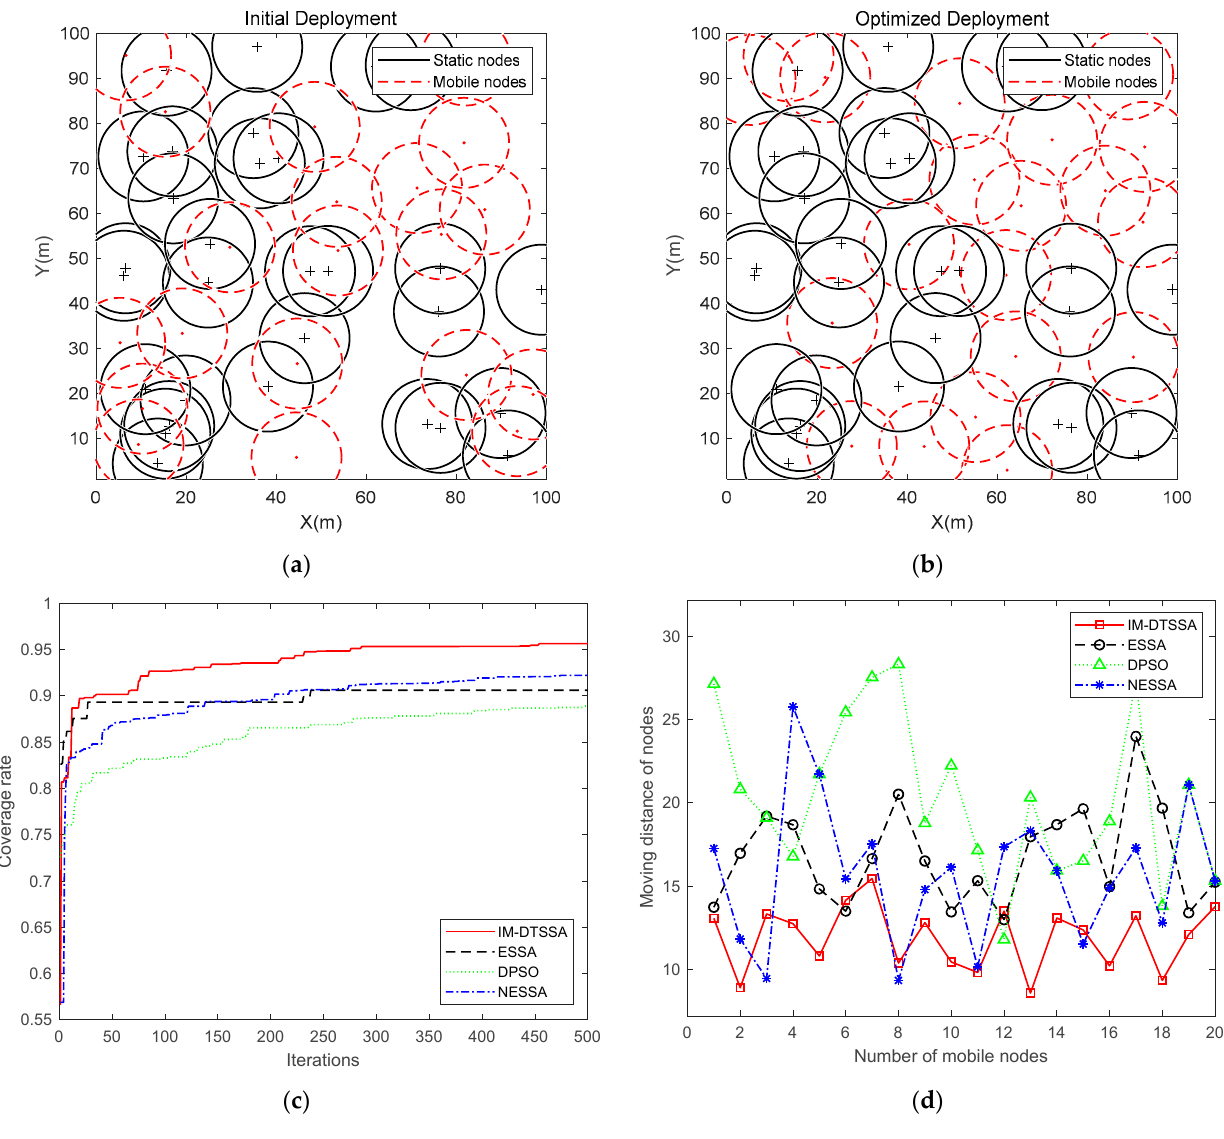
Figure 6. 100 m × 100 m coverage optimization comparison: ( a ) Initial Deployment; ( b ) Optimized Deployment; ( c ) Iteration curves of the four algorithms; ( d ) The moving distance of each node.